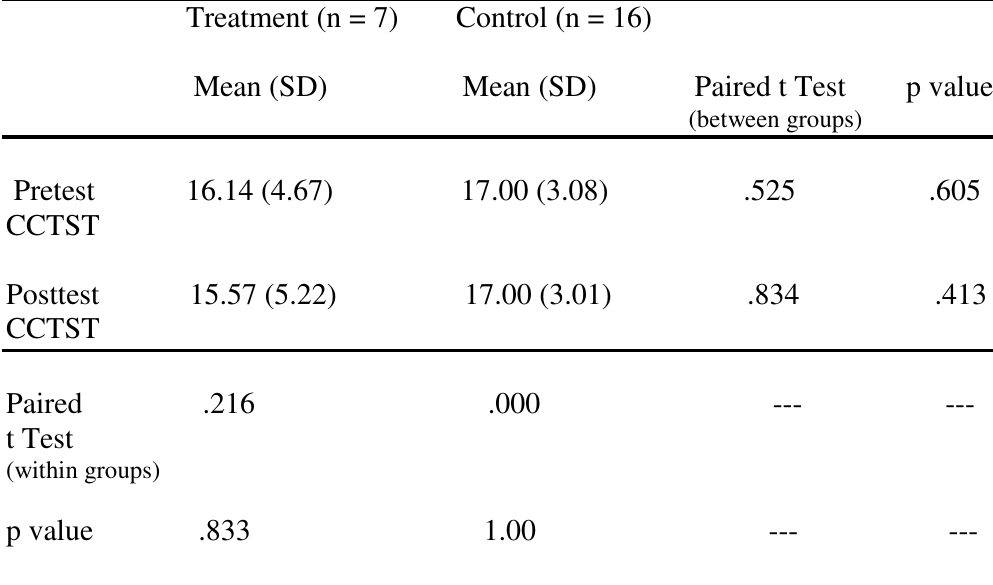
Comparison of CCTST Scores Within and Between